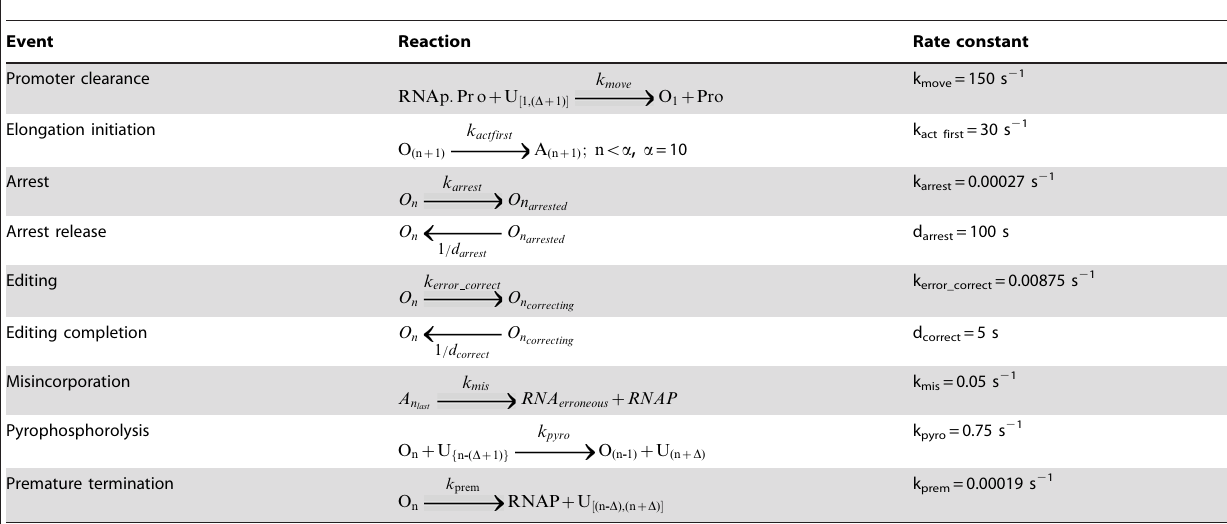
Table 1. Reactions and values of the rate constants of events during elongation other than pauses and stepwise elongation.